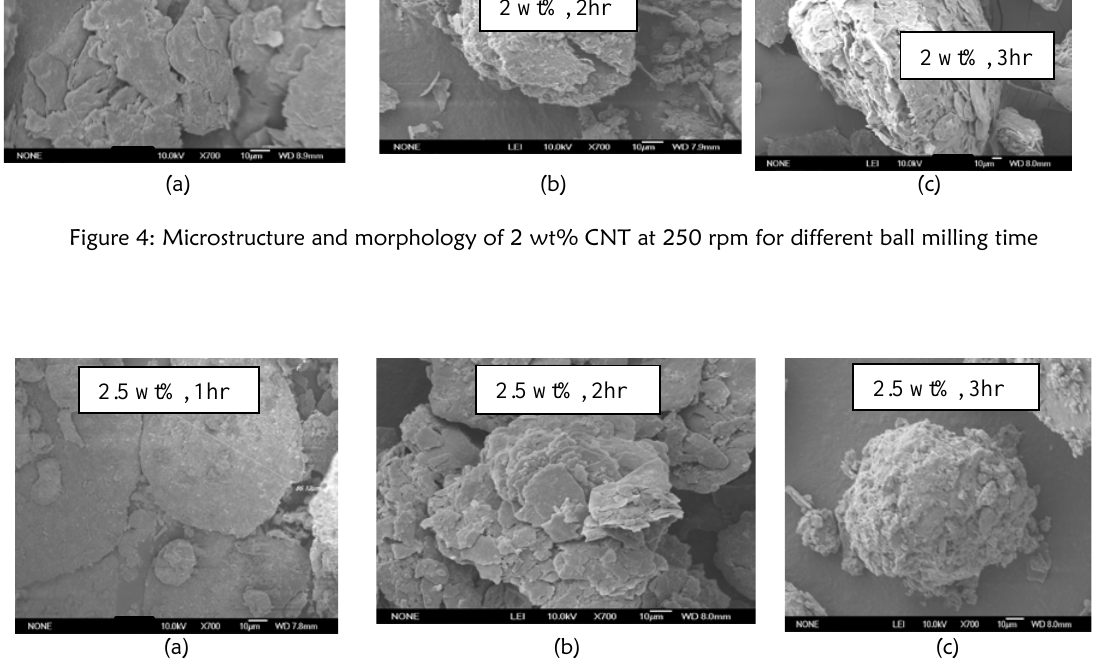
Figure 3: Microstructure of 2.5 wt% of CNT at 250 rpm for different ball milling